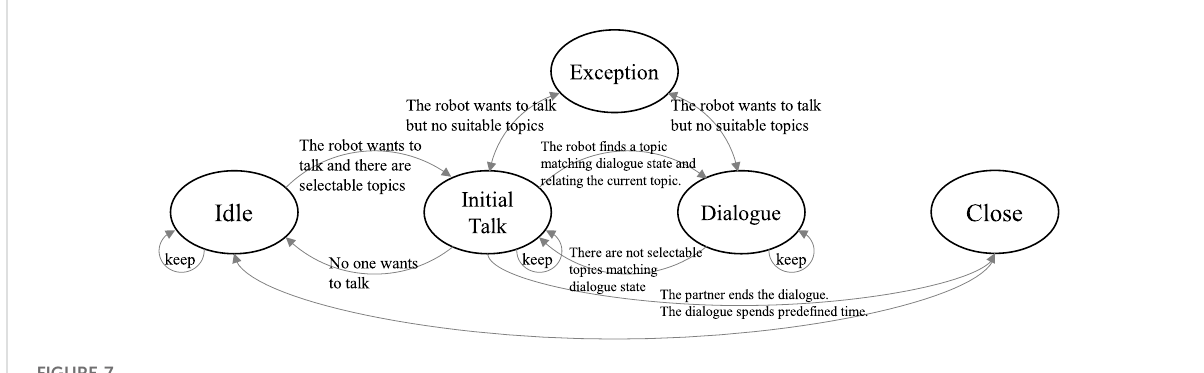
FIGURE 7 Transition of interaction states in the fi rst-meeting